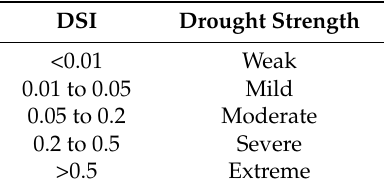
Table 1. Drought classification based on Drought severity index (DSI).